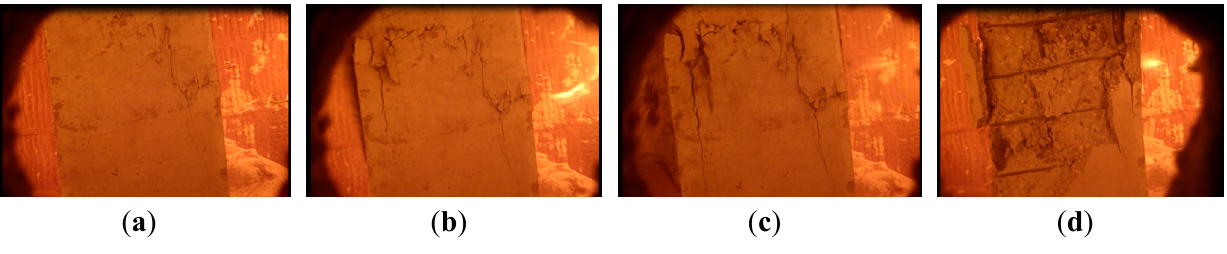
Figure 13. Concrete spalling observed from the observation port at different moments